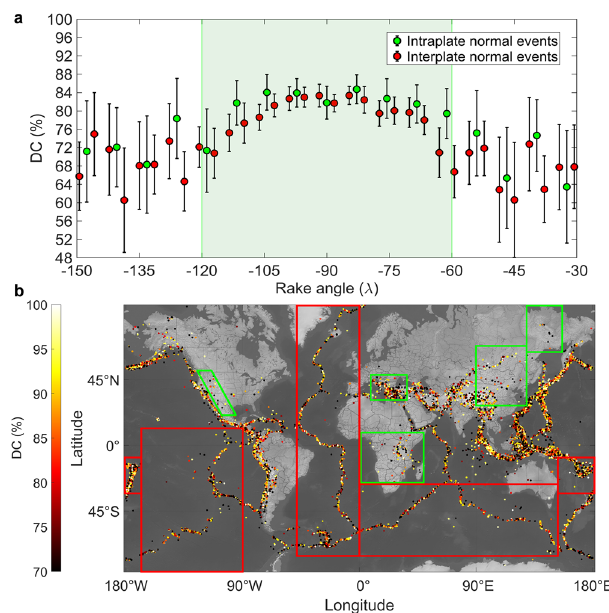
Fig. 7 Double-couple component of the seismic moment tensors in the GCMT catalogue for 5.3 ≤ M w ≤ 7.5 shallow (depth lower than 50km)